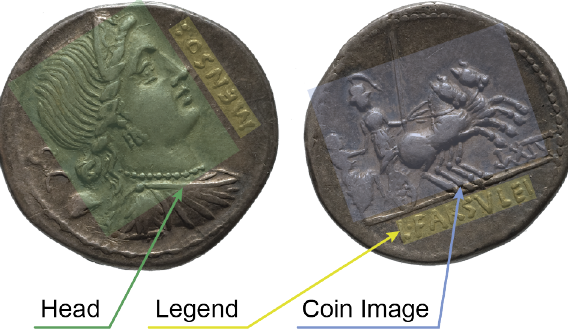
Figure 2: Overview of the ILAC project.